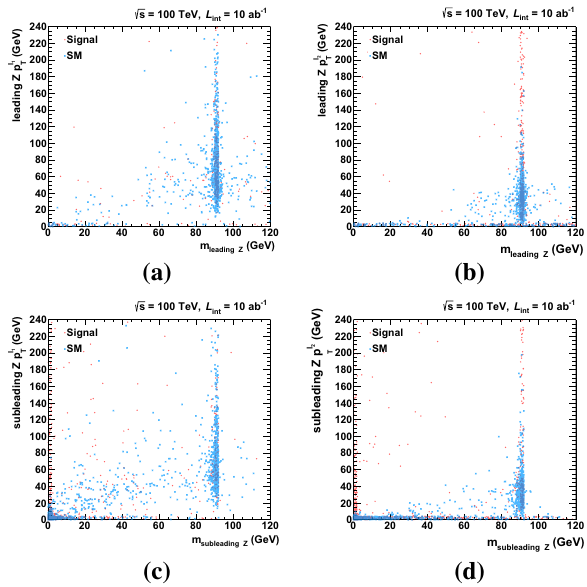
Fig. 3 Transverse momentum distributions of a leading lepton, b sub- leadingleptonoftheleading Z bosonvsitsinvariantmassandtransverse momentum distributions of c leading lepton, d sub-leading lepton of the sub-leading Z boson vs its invariant mass in the 4 e